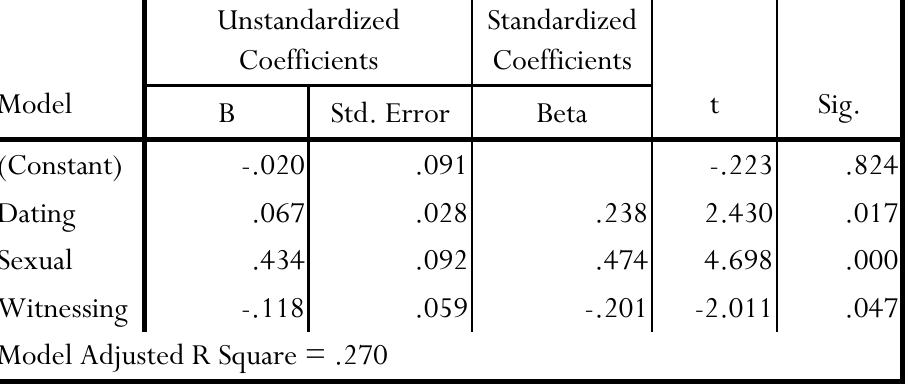
Table 19: Linear Regression of Number of Victimizations on Duration of Prostitution